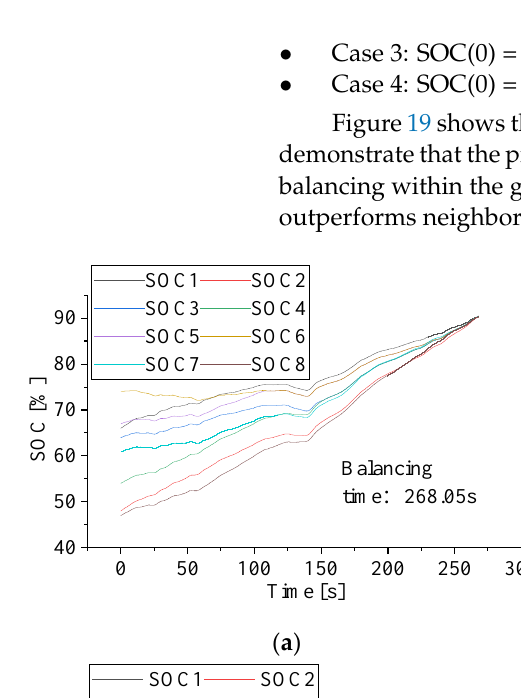
18 of 22 Figure 18. Lithium battery SOC change chart. (Adjacent equalisation circuits and SOC difference- based equalisation strategies)